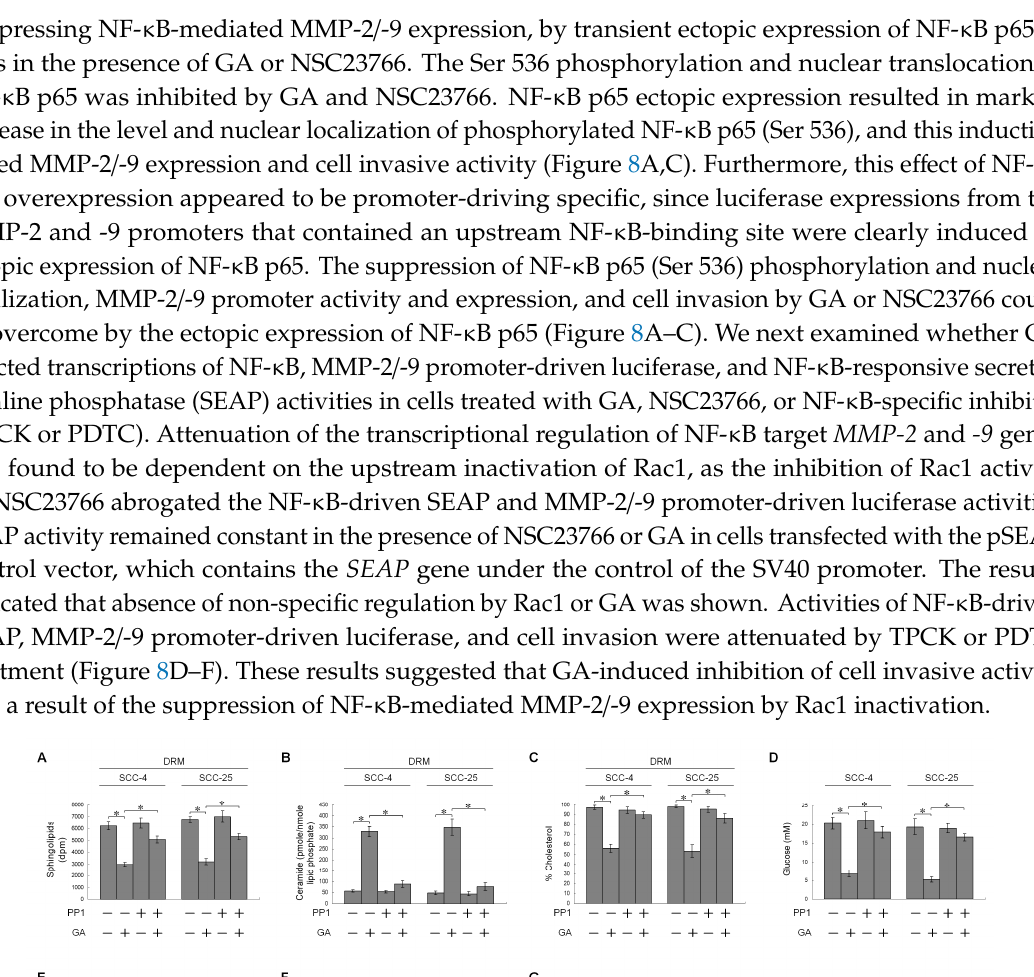
internal control for sample loading. The values above the figures represent relative density of the bands normalized to β